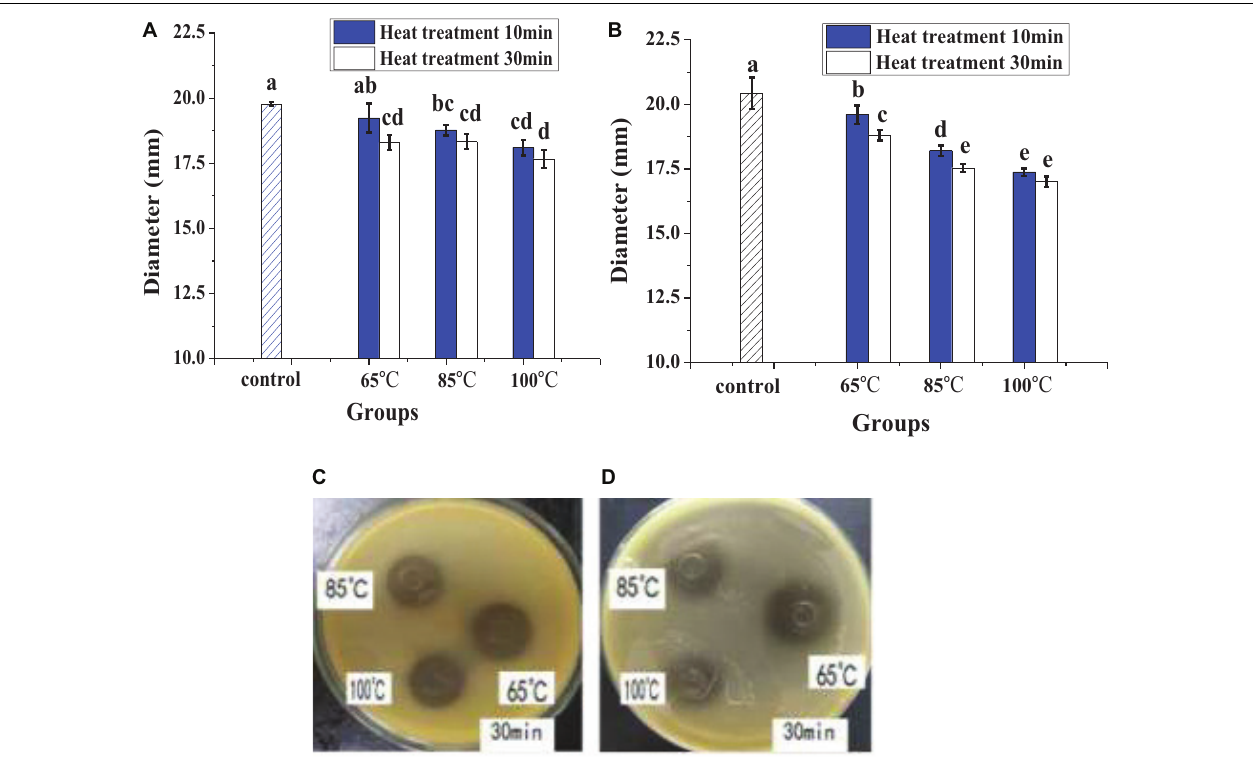
both weakened after being treated with papain and